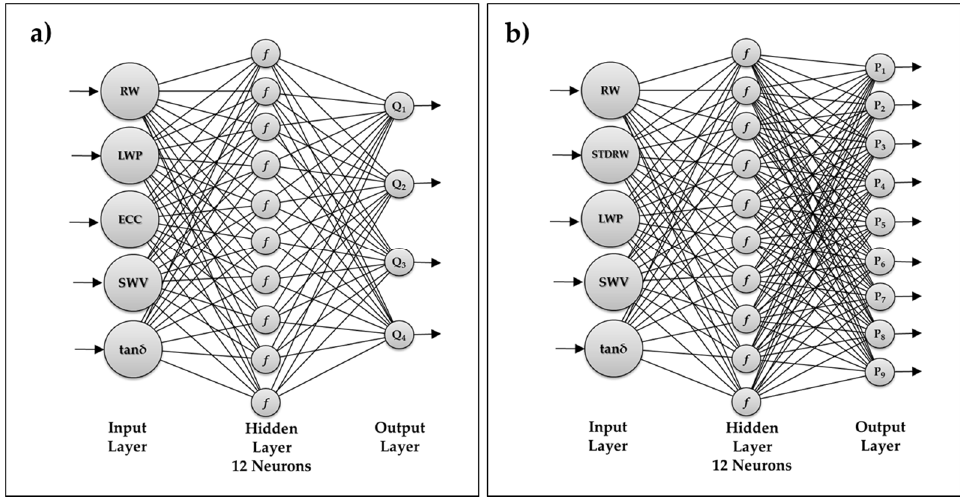
Figure 6. Topology of the artificial neural network built with an optimized set of input variables ( RW —mean ring width, STDRW —standard deviation of ring widths in individual log, LWP —latewood percentage, ECC —log eccentricity, SWV —stress wave velocity, tan δ —vibration damping) to classify logs into quality ( a ) and price classes ( b ). Q 1 –Q 4 —quality classes; P 1 –P 9 —price classes (lowest–highest).